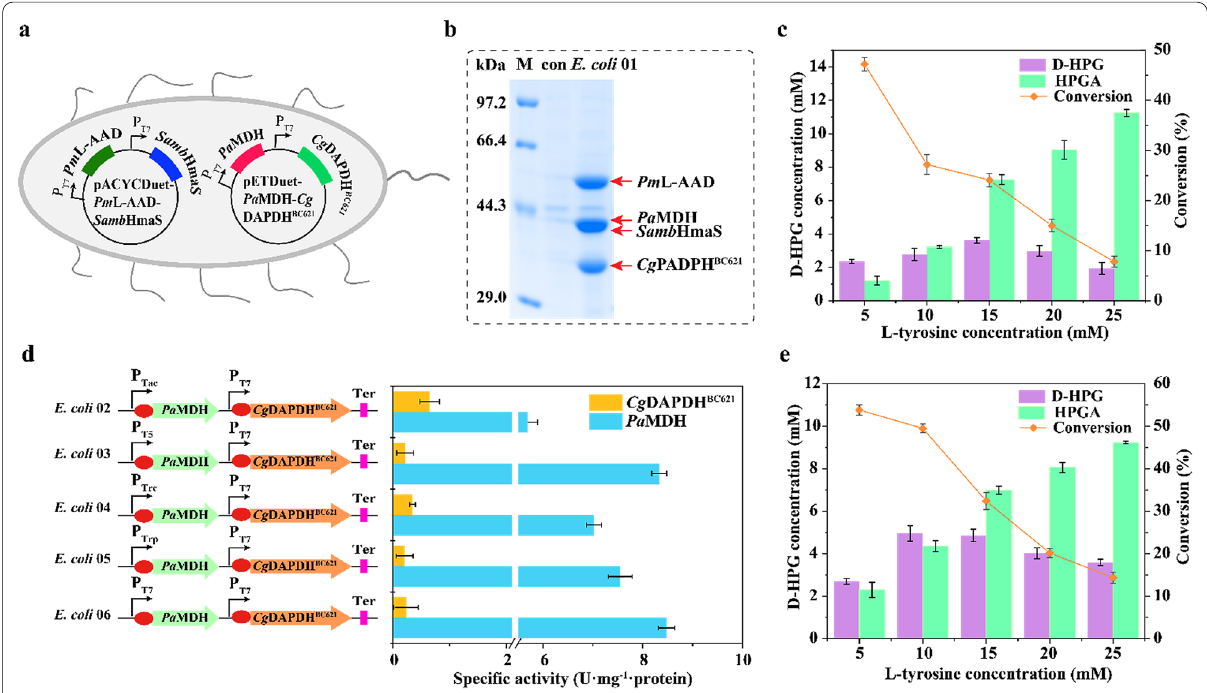
Fig. 3 In vivo construction and optimization of multi-step cascade reactions. a Strain E. coli 01 containing double plasmids to express Pm L-AAD, Samb HmaS, Pa MDH, and Cg DAPDH BC621 . b SDS-PAGE analysis of strain E. coli 01 from cell-free extracts. M, Maker; con, E. coli BL21 without overexpressing any enzymes. c Effect of substrate loading on D-HPG production by strain E. coli 01. d The specific activity of Pa MDH and Cg DAPDH BC621 in recombinant strains with different promoter sequences. e Effect of substrate loading on D-HPG production by strain E. coli 02. The reactions were supplemented with varying concentrations of L-tyrosine from 5 to 25 mM and 20-g/L wet cell added at 30 °C. The conversion and titer were obtained after completion of the reactions and determined by HPLC analysis. The values are averages of three